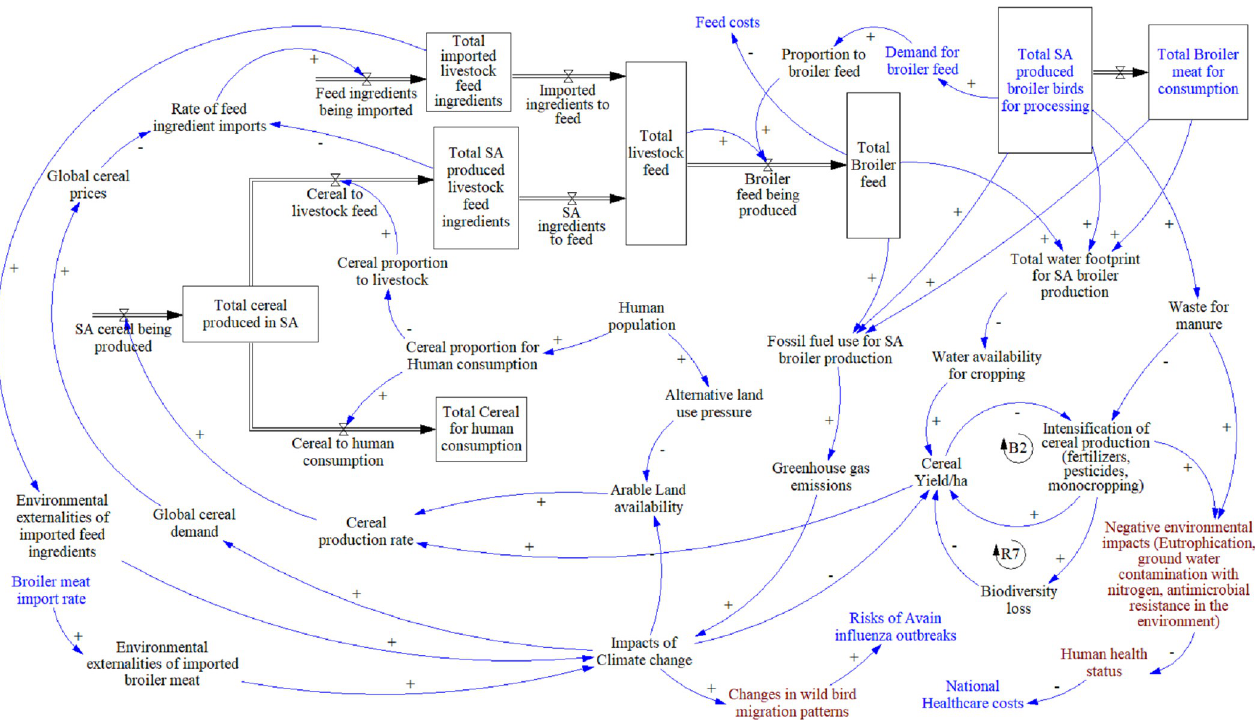
Fig 5. Feed and environment module. Key: Blue text: elements linking to other modules, Brown text: elements added after meeting with stakeholders.